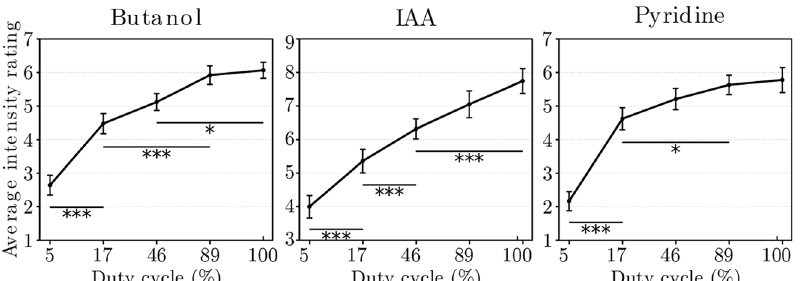
Fig 9. Averaged intensity ratings. Graph shows averaged intensity ratings ( ± standard error) of the five α for butanol, IAA and pyridine. * : p < 0.05, ** : p < 0.01, *** : p <